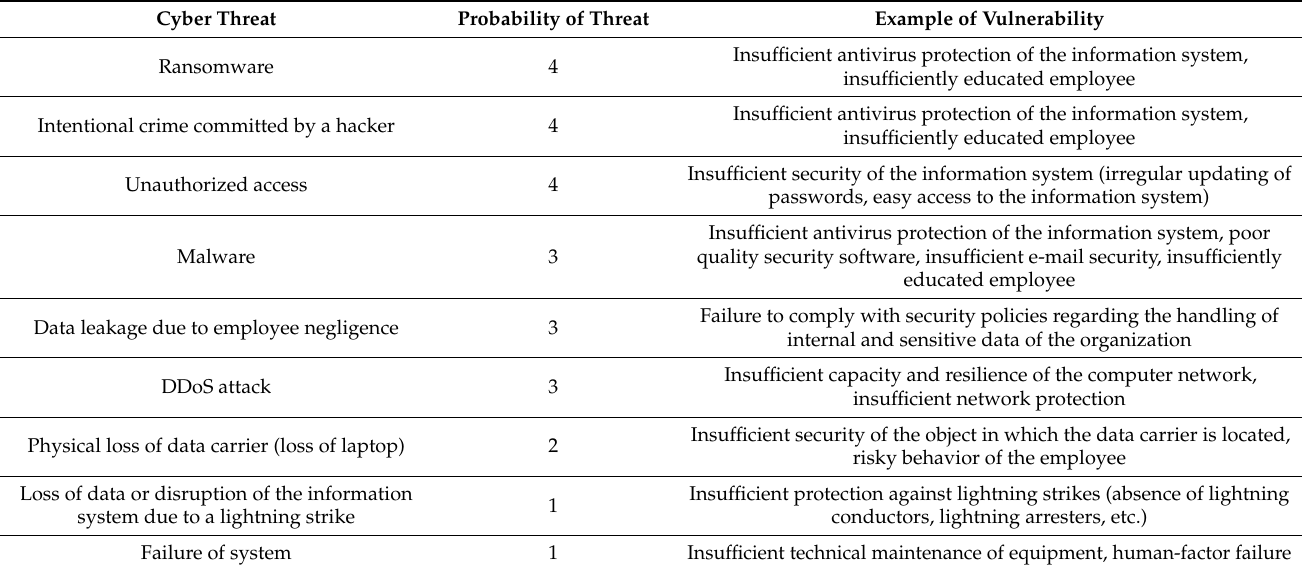
Table 4. Probability of cyber threats (own resource).